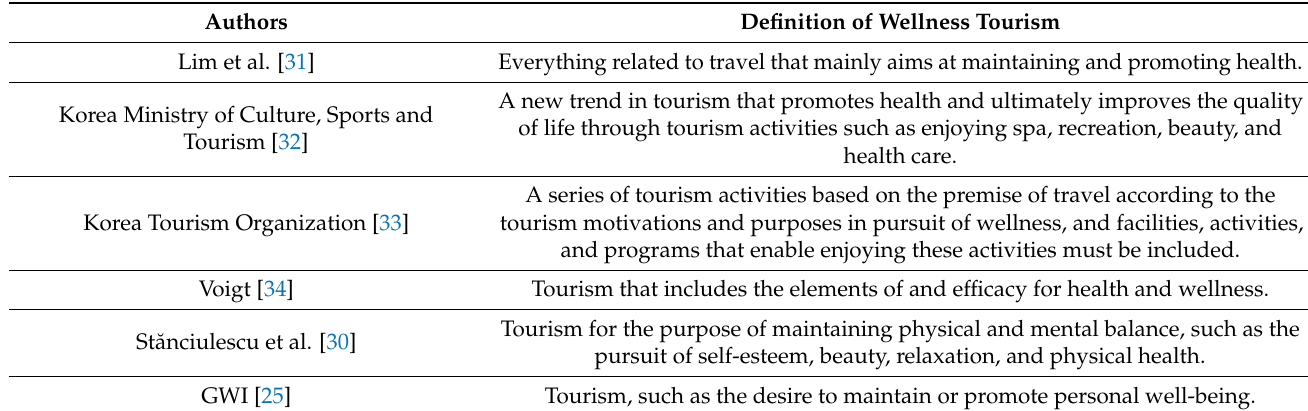
Table 1. Previous studies on wellness